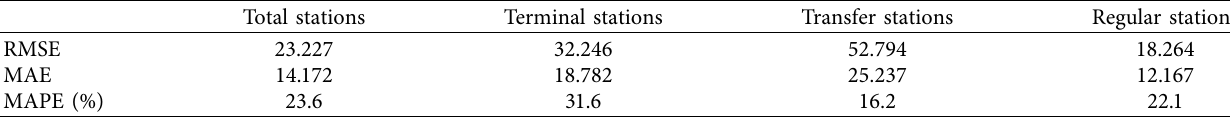
Table 3: Performance of the proposed HSTDL-net for inbound passenger flow.